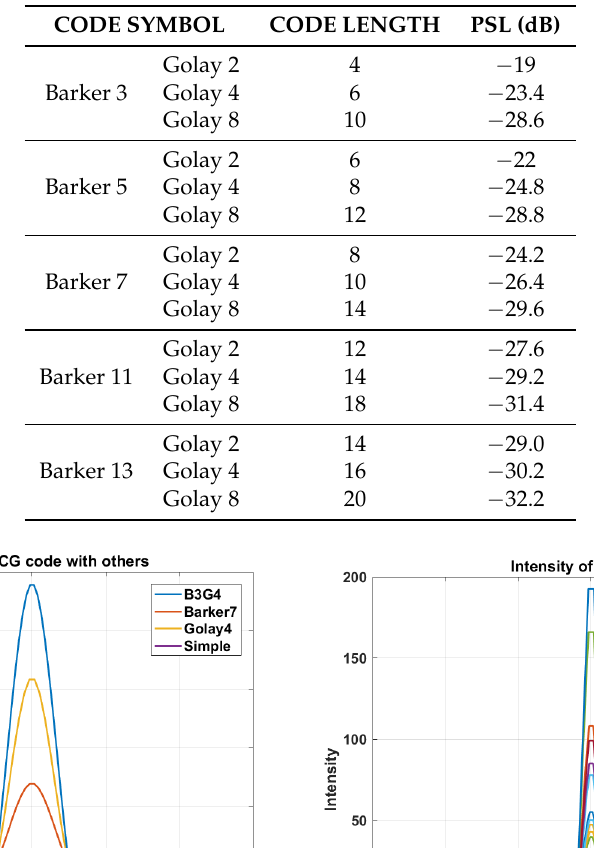
Table 2. Different lengths and peak-sidelobe ratio of BCG code.